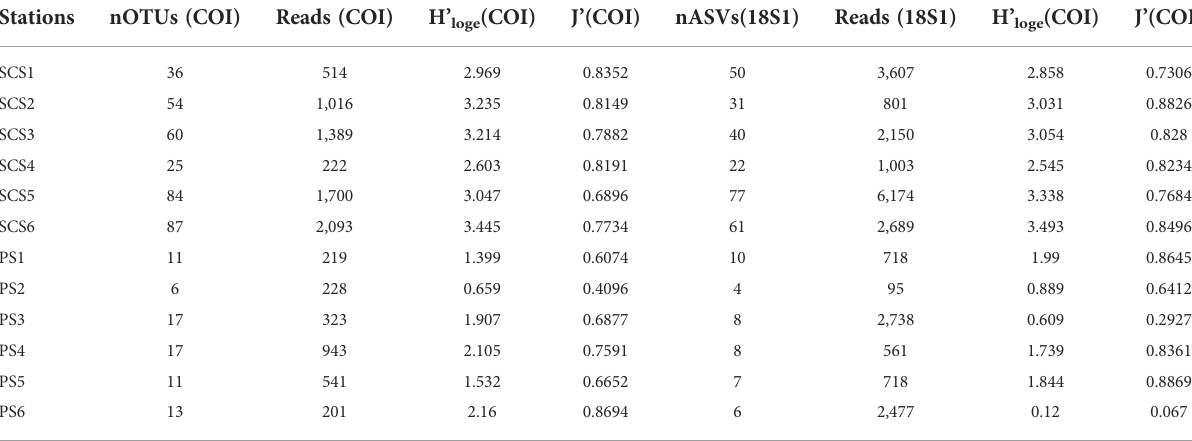
TABLE 1 Summary of meroplankton OTUs/ASVs number, reads, Shannon diversity (H ’ loge ) and Pielou evenness (J ’ ) per station for two primers (COI and 18S1).